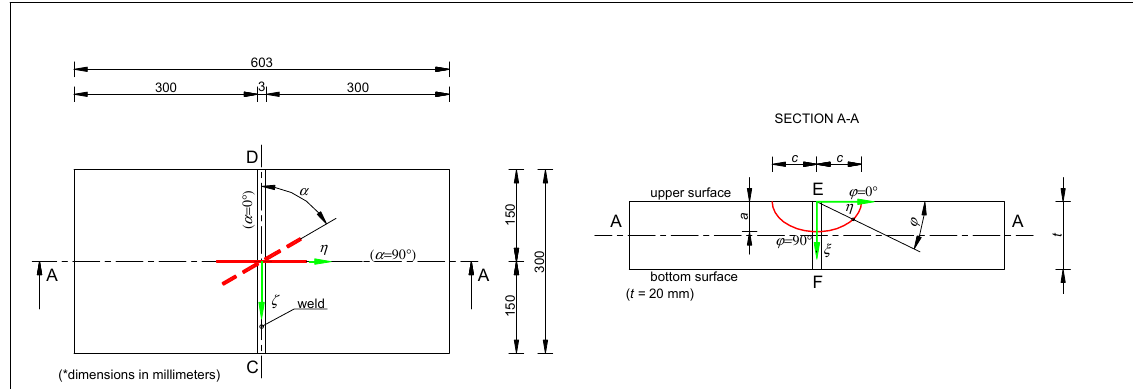
Figure 3. Illustration of shape, dimensions, location, and orientation of cracks over the weld line.